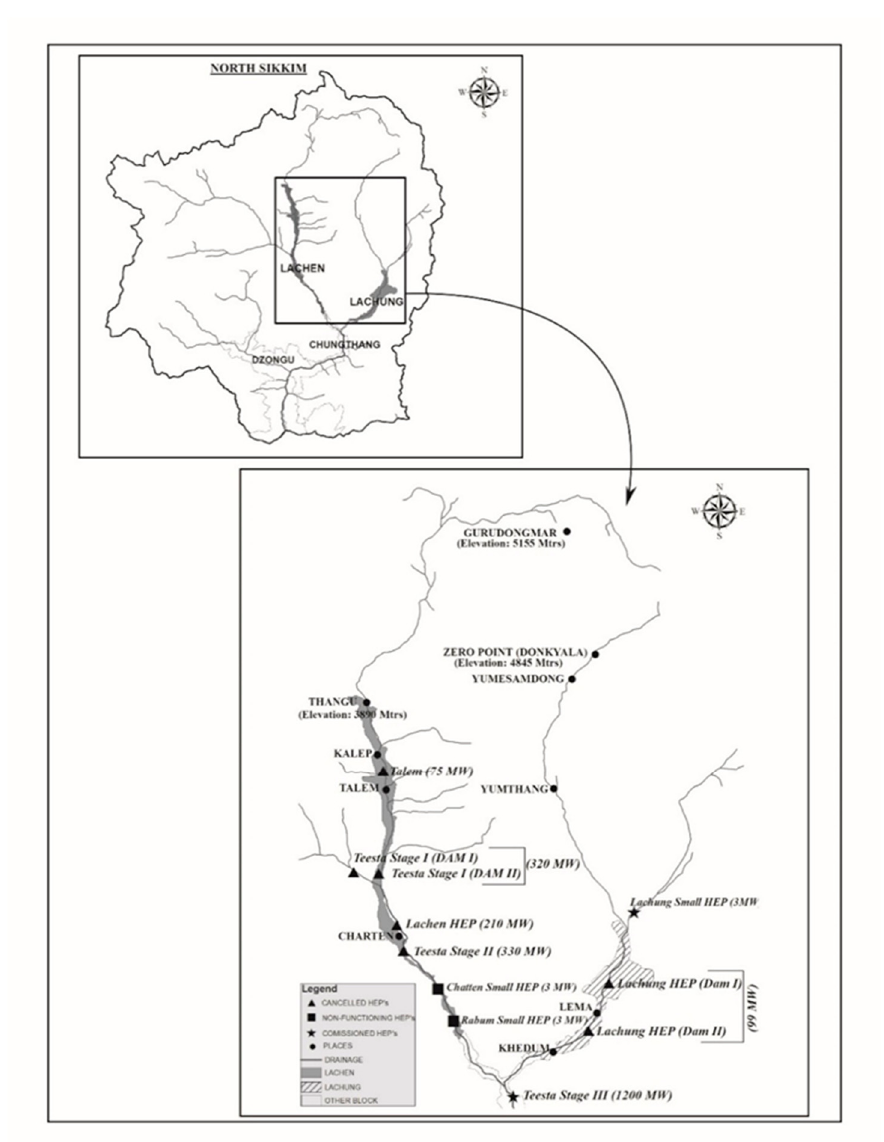
Figure 2. Hydropower Dams in Lachung and Lachen. Source: Own elaboration, adapted from GoS websites. Map not to scale.